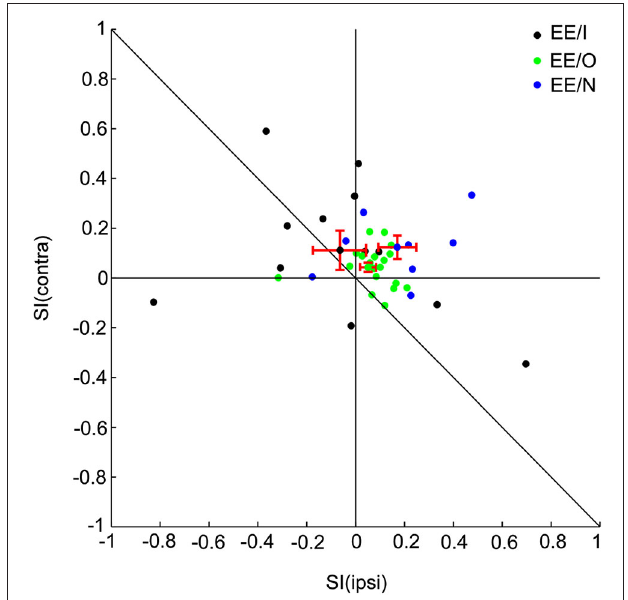
FIGURE 2 | Population analysis of SSA for all the EE neurons. Scatter plot of SI (contra) vs. SI (ipsi) of EE/I (black), EE/O (green) and EE/N (blue) neurons.